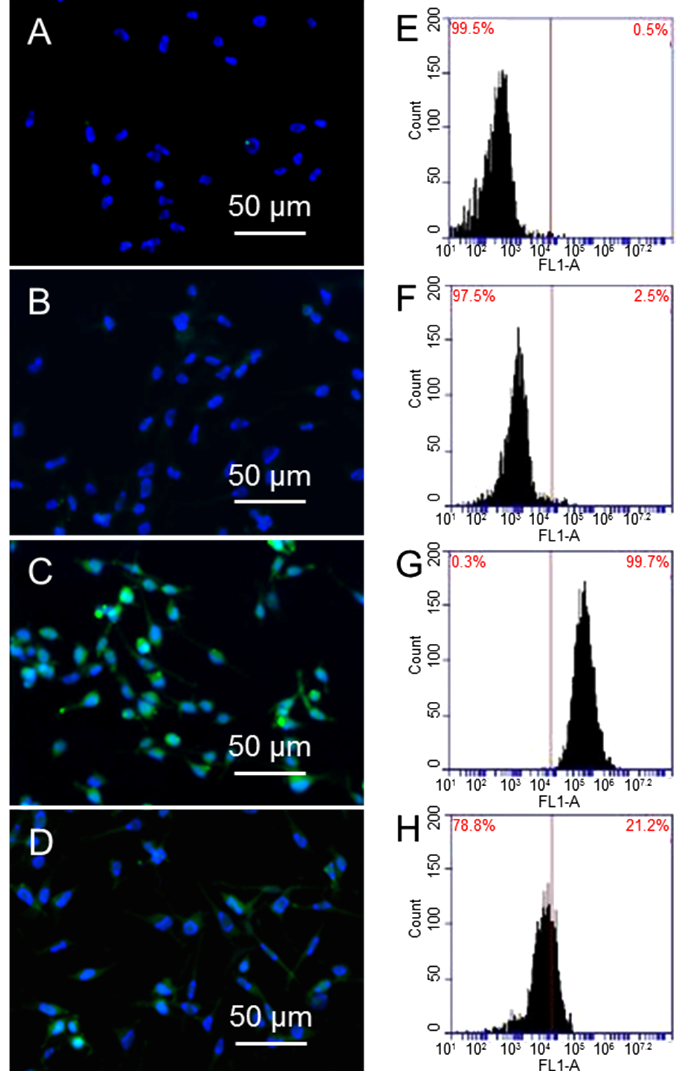
cells treated with 10 µg/mL GO ( B ); cells exposed to 1.25 Gy X-ray ( C ); and cells treated with 10 µg/mL GO and then exposed to 1.25 Gy X-ray ( D ); Flow cytometry results of cells after different treatment: cells ( E ); cells treated with GO ( F ); cells exposed to 1.25